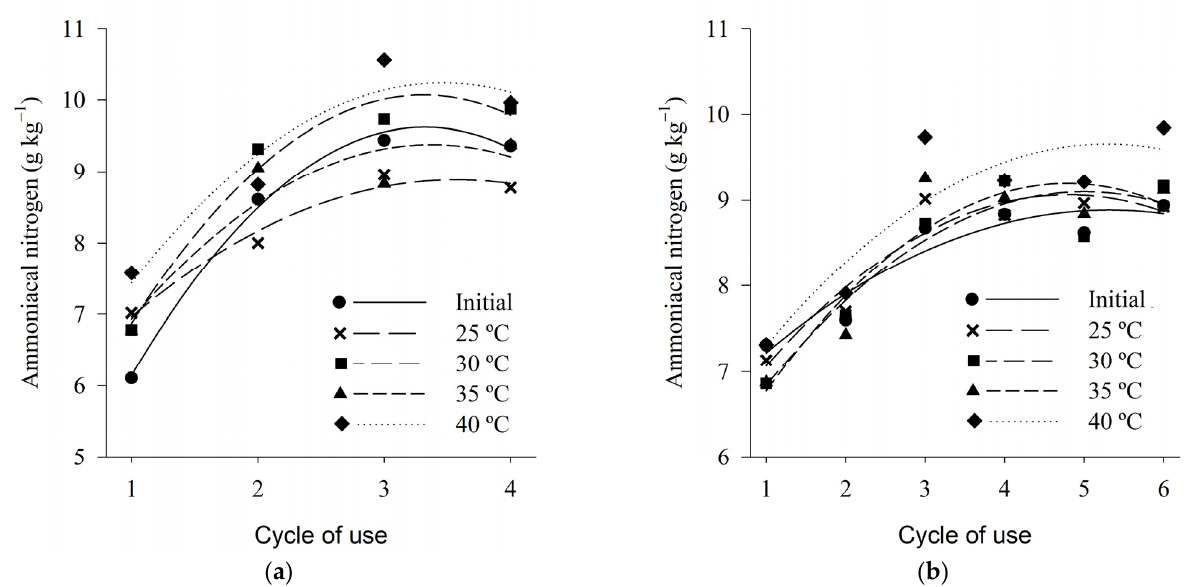
Figure 8. Ammonia nitrogen of wood shaving bed ( a ) and coffee husk bed ( b ) samples in different cycles of use and heat treatments.